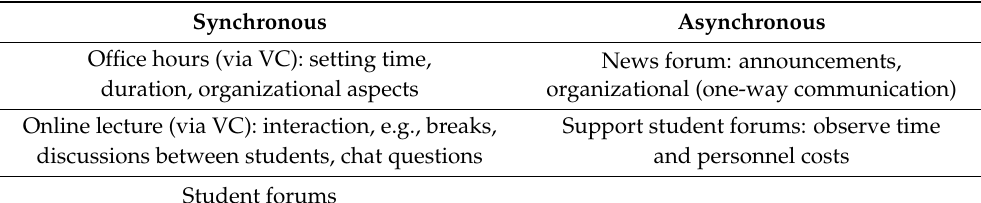
Table 3. Synchronous and asynchronous teacher-to-student communication (after [3]). Synchronous